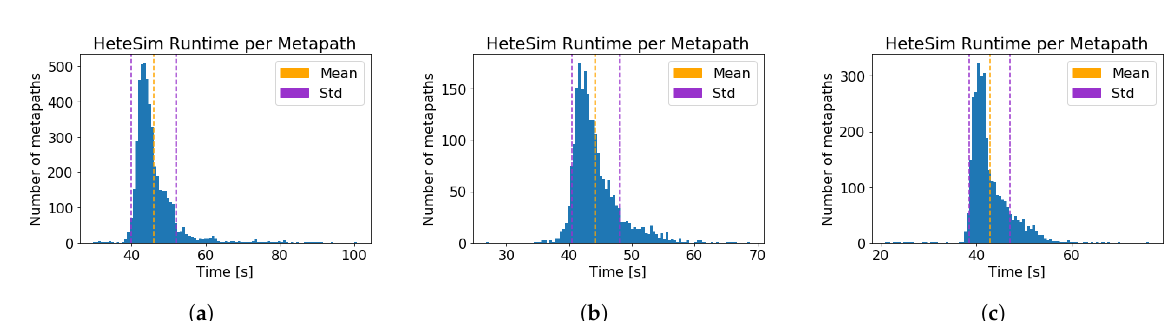
Figure 3. Distribution of SemNet version 1 HeteSim computation times for all metapaths joining the given source node and Alzheimer’s disease. ( a ) Insulin; ( b ) Hypothyroidism; ( c ) Amyloid.